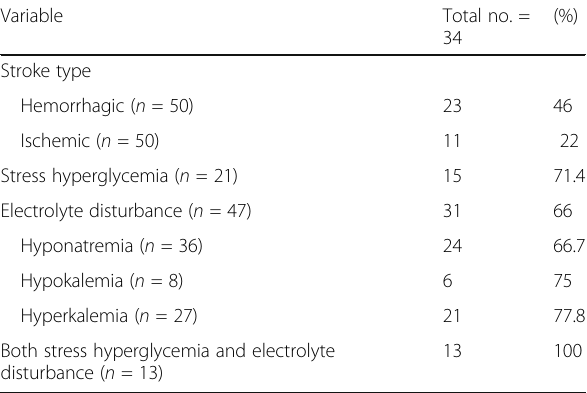
Table 4 Distribution of stroke patients according to the mortality